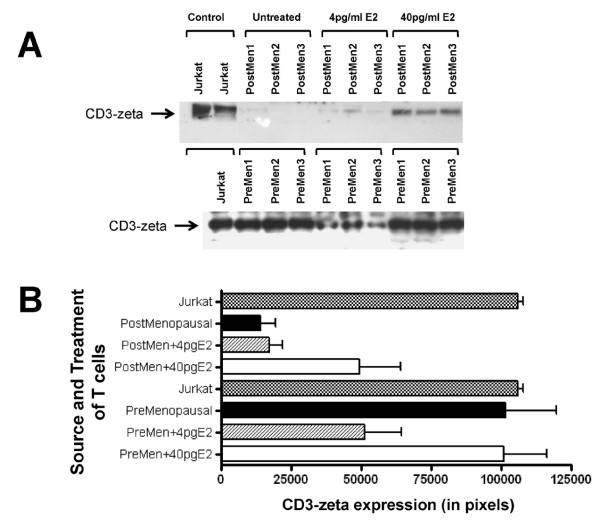
Modulation of normal T cell CD3-zeta protein expression by physiologic estradiol concentrations. Expression of CD3-zeta protein expression by T cells isolated from either normal premenopausal or postmenopausal female volunteers, assayed immediately after isolation and following an incubation in the presence of either 4 pg/ml or 40 pg/ml estradiol for 48 hours defined by Western immunoblotting. The bar graph presents the quantitation of triplicate digitized gel images expressed as mean ± standard deviation. The insert shows a representative Western blot gel image.